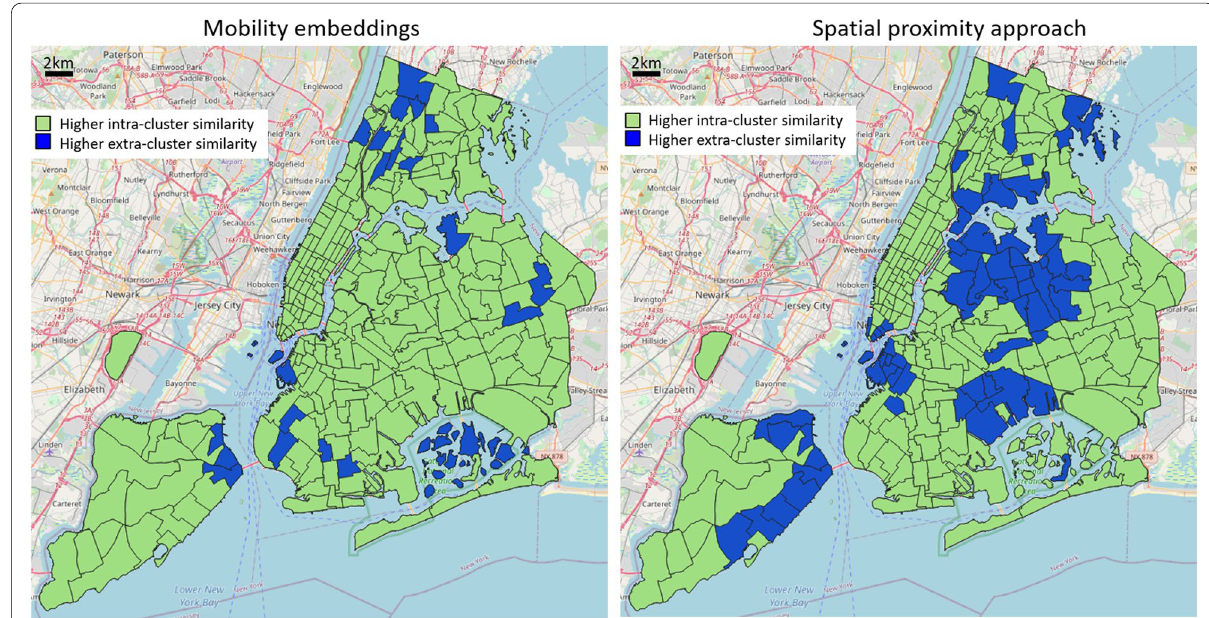
Fig. 6 Assessment of functionality cluster consistency according to residential and tourist-related functionality classes. Results are reported in terms of “winning” or “losing” similarity scores for each reference area (green if its intra-cluster similarity is higher than its extra-cluster one; blue if